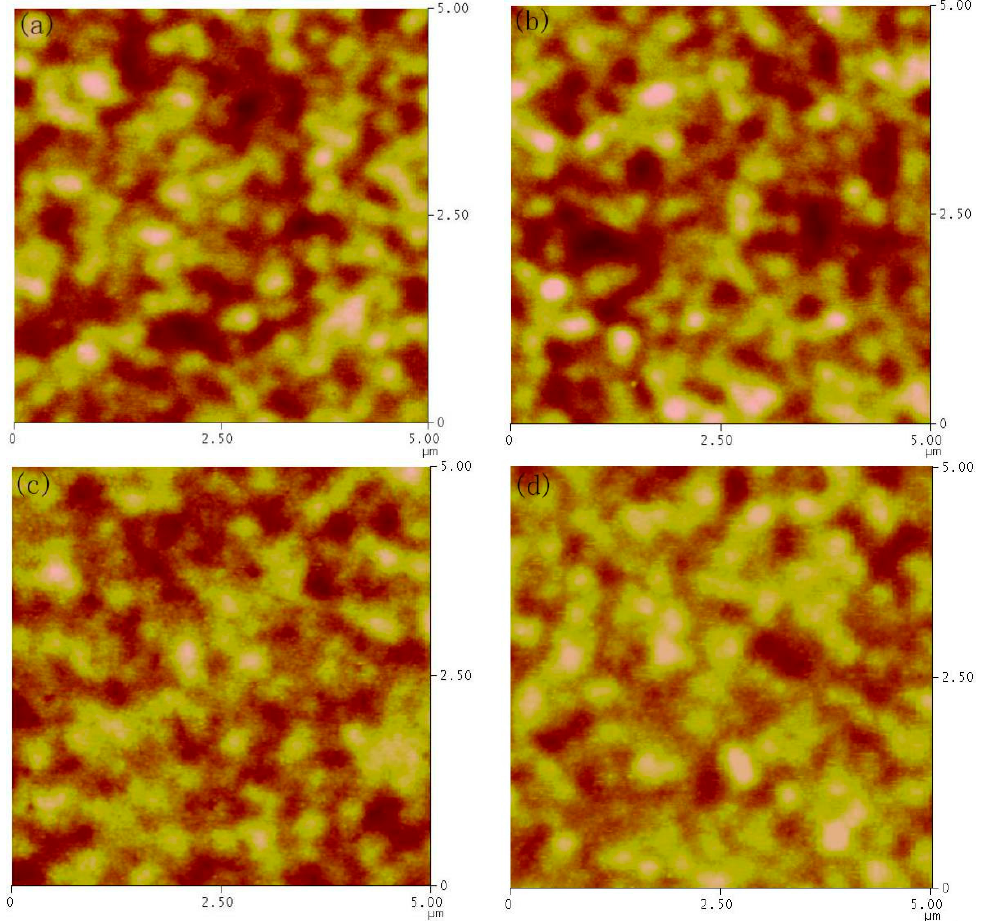
Figure 7. AFM (atomic force microscope) images for PbS CQDs thin film fabricated by using different n-octane/toluene solvent ( a ) 5% toluene ( b ) 10% toluene ( c ) 20% toluene ( d ) 40% toluene.